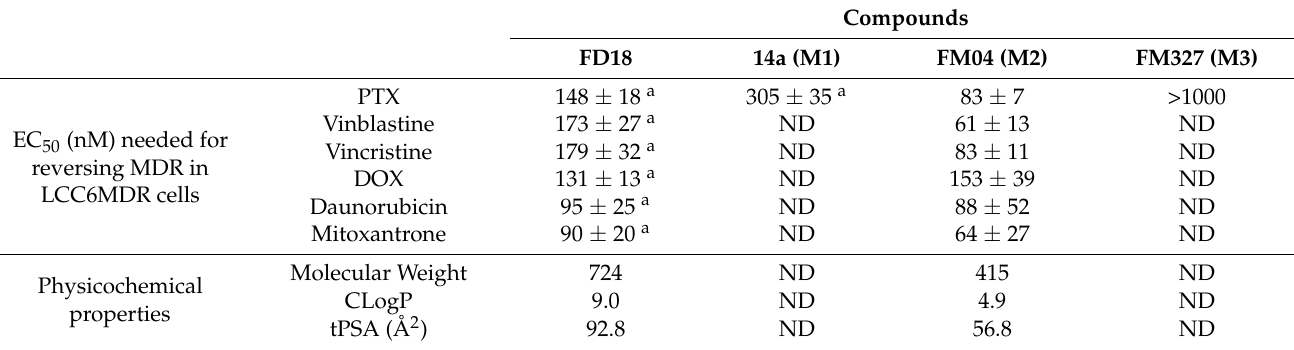
Table 1. EC 50 (nM) of FD18 metabolites in reversing P-gp mediated